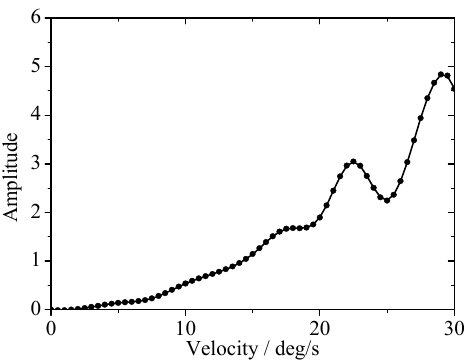
Figure 8. Radial vibration amplitude of the planet carrier at different rotational velocities.